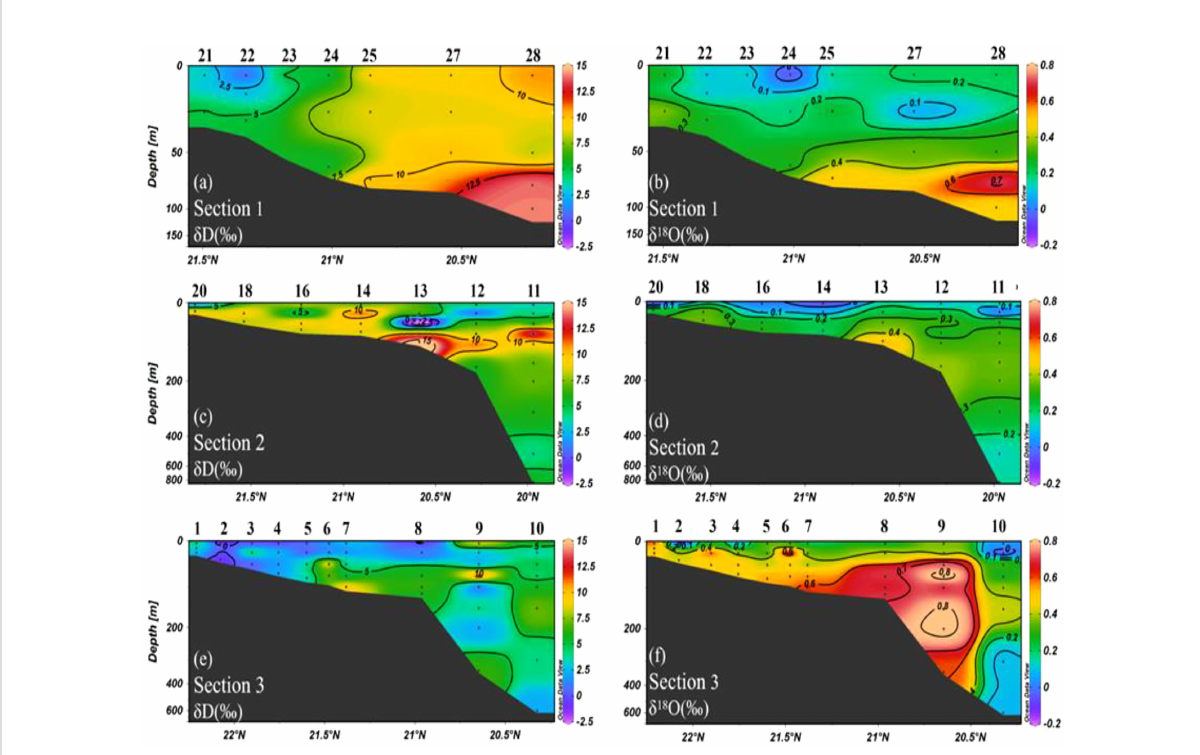
FIGURE 3 Vertical distribution of d 18 O and d D in three sections as de fi ned in Figure 1. Note that the depth scale is not linear where the upper 400 m was stretched.